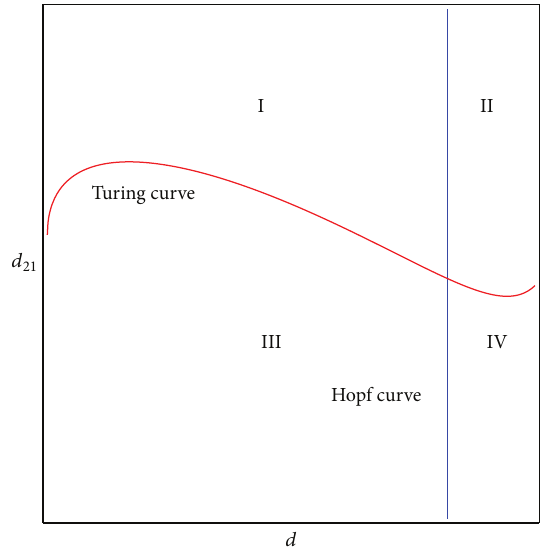
Figure 1: Bifurcation diagram for model (11) in the 𝑑 − 𝑑 21 parameter space. The red line is Turing bifurcation curve, and the blue line denotes Hopf bifurcation. Domain I is the region of pure Turing instability. In domain II, Hopf-Turing instability occurs. And domain III is the stable region. Domain IV is the region of pure Hopf